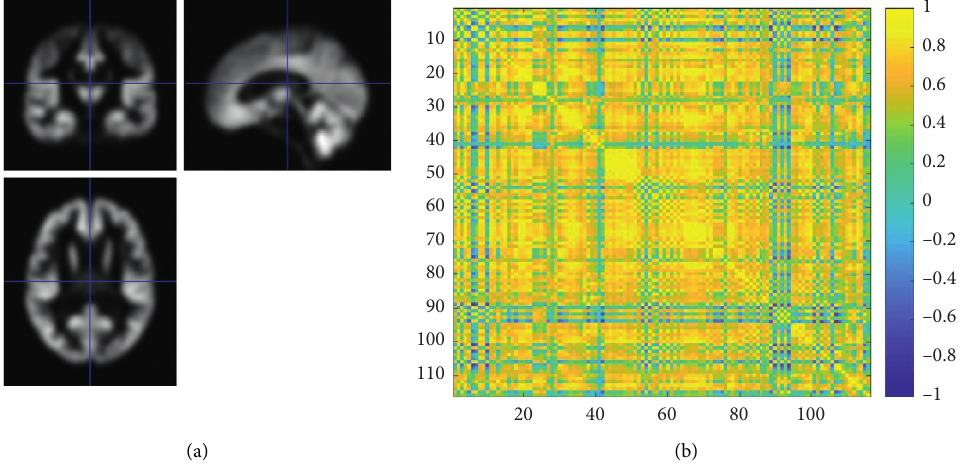
Figure 1: Preprocessing results of (a) sMRI data and (b) fMRI data.